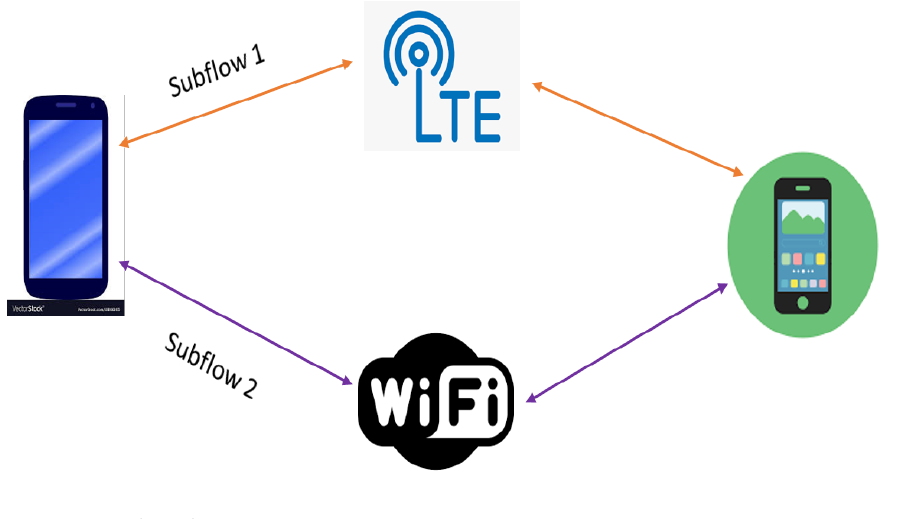
Figure 1. Multipath